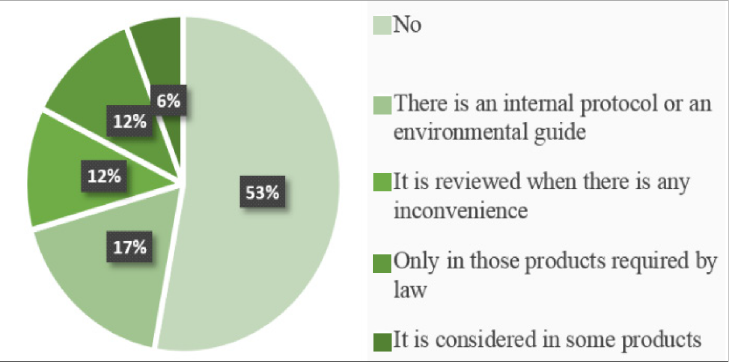
Figure 3. Green purchase